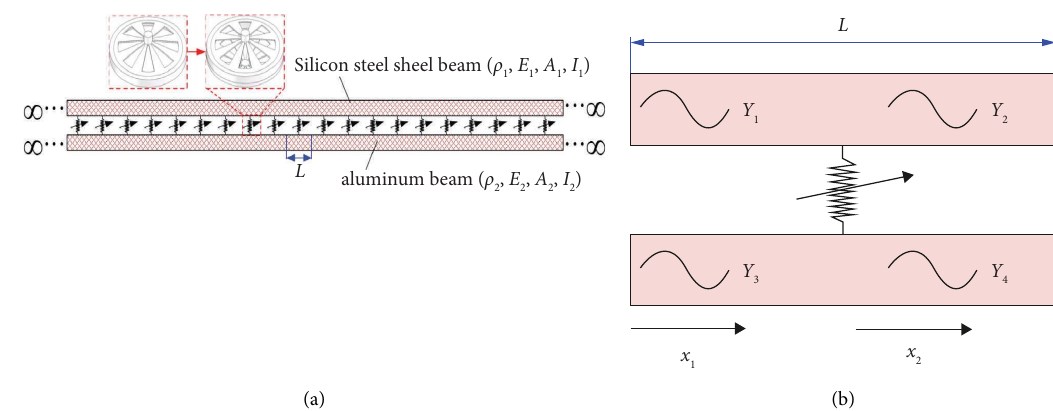
Figure 3: Double-beam metamaterial: (a) mechanical model of double-beam metamaterial and (b) unit cell of double-beam metamaterial.